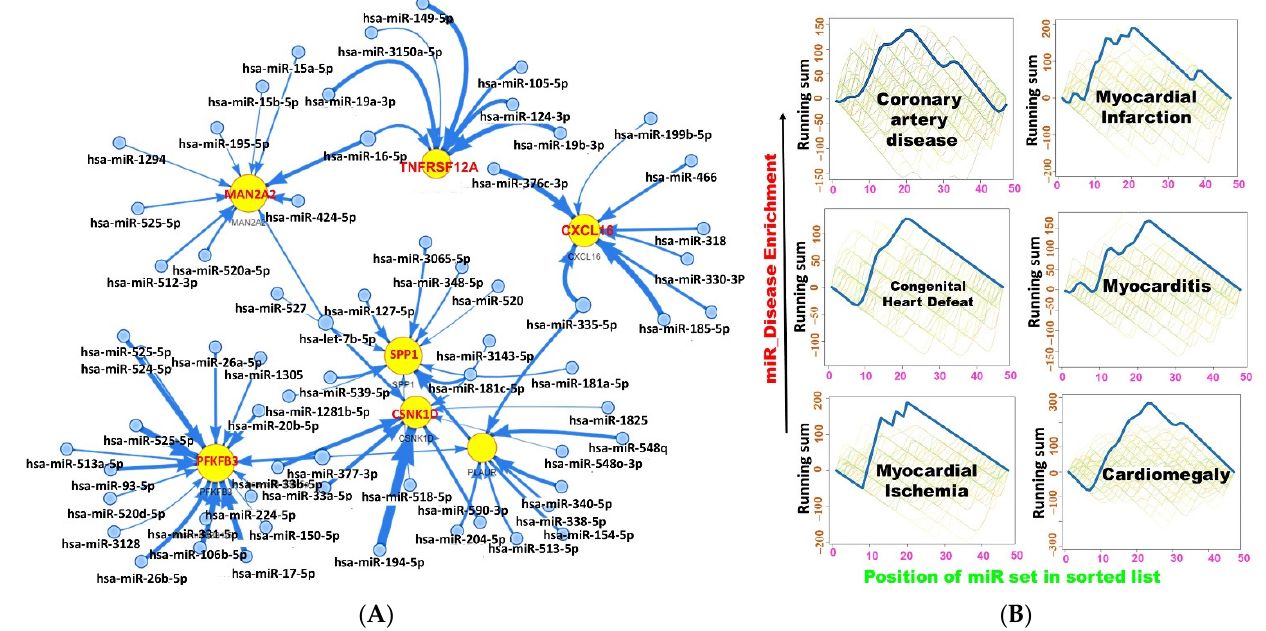
Figure 6. The micro (mi)RNA regulatory network and enrichment of the MTSCPPC signature ( A ) The VisNetwork miRNA regulatory network of the MTSCPPC signature. ( B ) Heart-related disease enrichment plots of the signature.